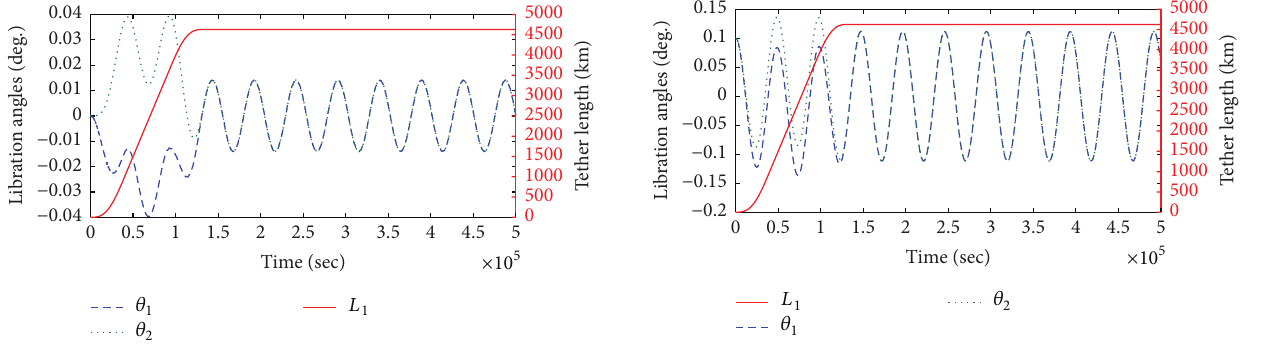
Figure15:Librationangles 𝜃 1 (𝑡) and 𝜃 2 (𝑡) asfunctionsoftimebased on the prescribed function 𝐿 1 (𝑡) on a circular